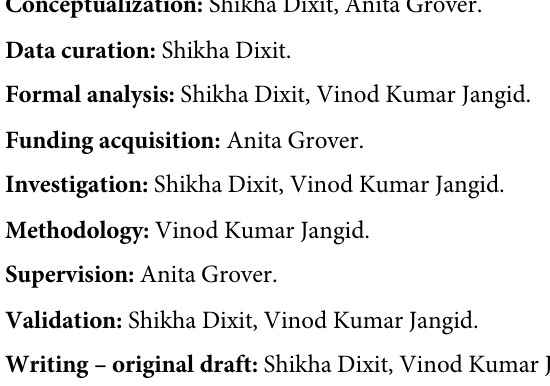
S1 Fig. Melt curve generated for seven candidate reference gene in B . juncea samples. S2 Fig. Melt curve generated for all the seven candidate reference gene in C . sativa samples . S3 Fig. Amplification efficiencies of the designed primers of all candidate reference gene in B . juncea . S4 Fig. Amplification efficiencies of the designed primers of all candidate reference gene in C . sativa